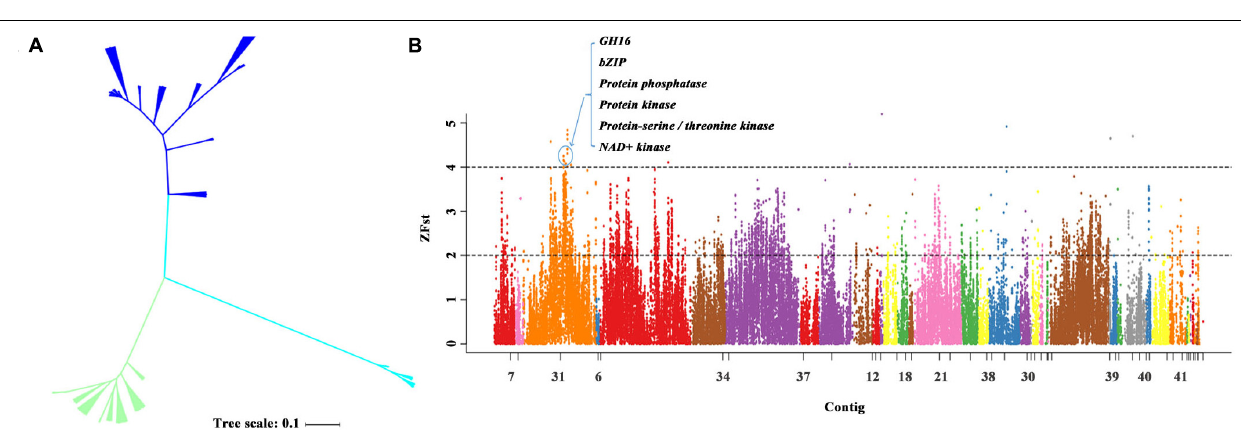
FIGURE 4 | The genetic diversity and genome selection of P. eryngii var. e ryngii and var. ferulae populations. (A) The genetic tree of the 37 strains including 19 P. eryngii var. e ryngii , 14 var. ferulae strains, and four P. tuoliensis. (B) The genome selection region of P. eryngii var. e ryngii and var. ferulae populations using the reference genome